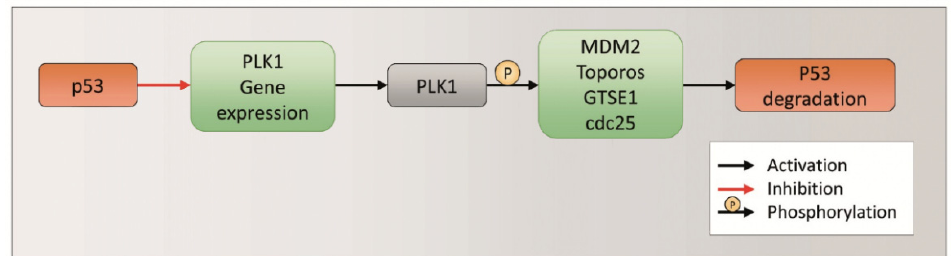
Figure 5. p53 and PLK1 expression and degradation regulation.